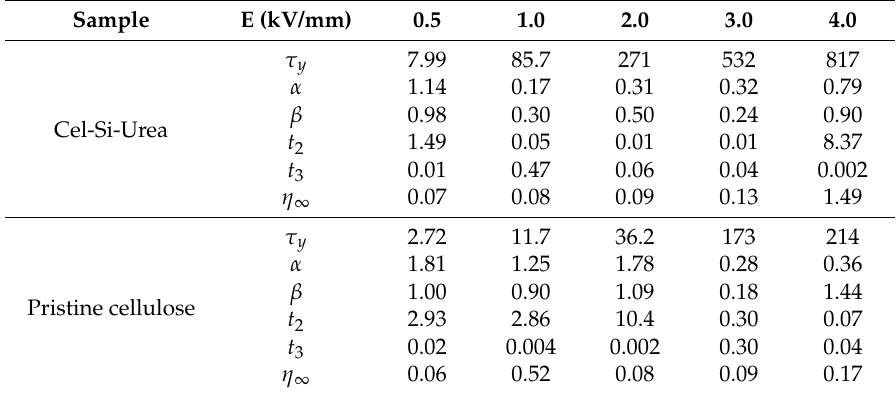
Figure 8. Shear stress vs. shear rate at different electric field strengths for the ER fluids of pristine cellulose ( a ) and Cel-Si-Urea ( b ) (symbols: experimental, lines: fitting of CCJ model to experimental points). Table 1. Parameters of CCJ model (Equation (5)) obtained from the fitting of shear stress curves of the ER fluids.